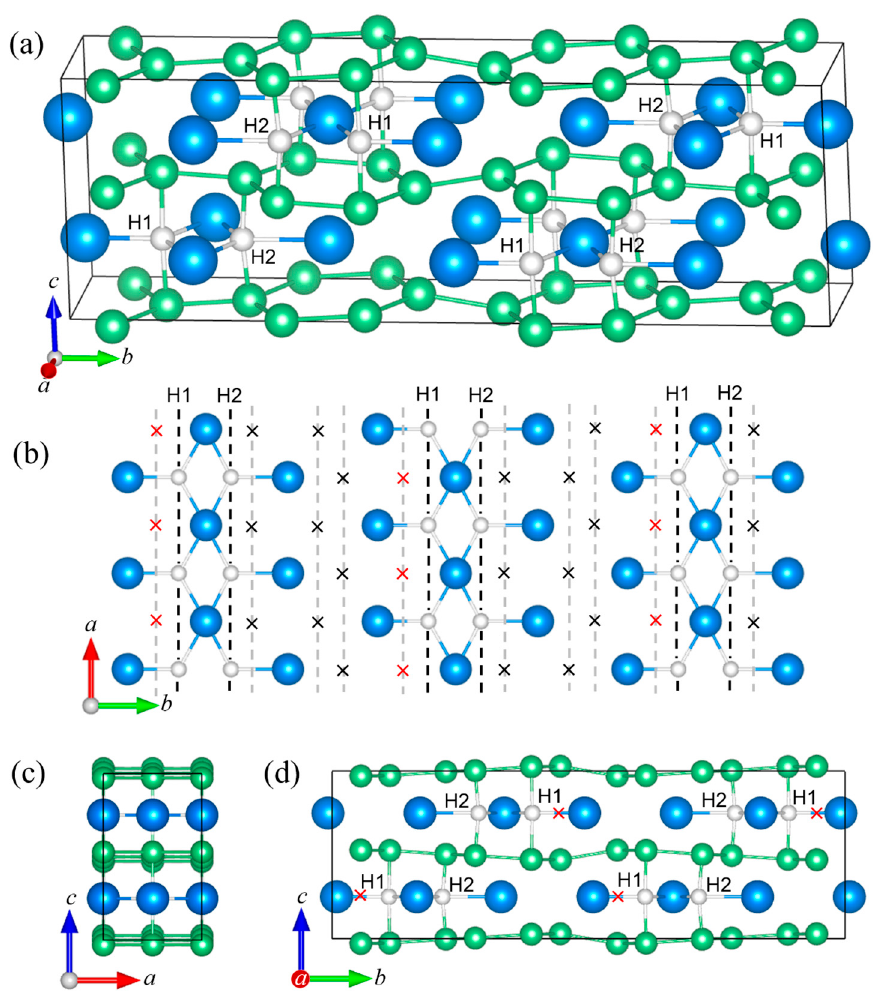
Figure 4. ( a ) Orthorhombic Cmcm crystal structure of ZrBe 2 H 0.67 . Blue, green, and white spheres represent Zr, Be, and H, respectively. Like the hexagonal P 6/ mmm ZrBe 2 H x structure in Figure 1, alternate ab -planar layers of Zr and Be atoms form the parent ZrBe 2 structure with H atoms occupying specific trigonal Zr 3 (4 c ) sites in the Zr planes, which cause a rippling of the Be layers. ( b ) View along the c -axis, showing just the Zr layer, and the ordered pattern of H-site occupation forming double chains of H atoms along the a -axis. Each double chain is comprised of one chain each of crystallographically distinct H1 and H2 atoms. Four parallel chains of vacancies (×) separate neighboring double chains. Red vacancies represent a third 4 c site (H3) for possible H occupation appearing at higher temperatures. ( c ) View along the b -axis. ( d ) View along the a -axis.